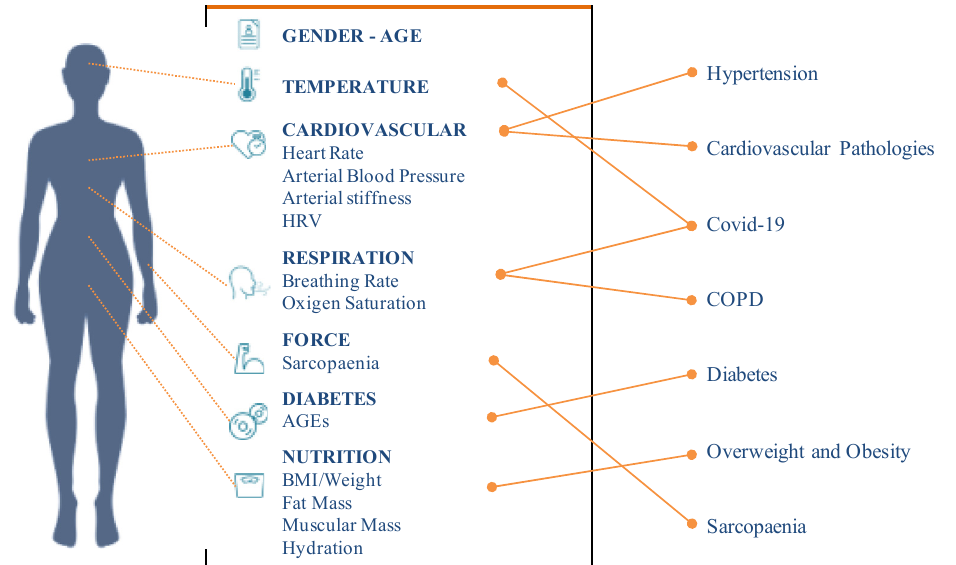
Figure 6. Personalized protocols for prevention.